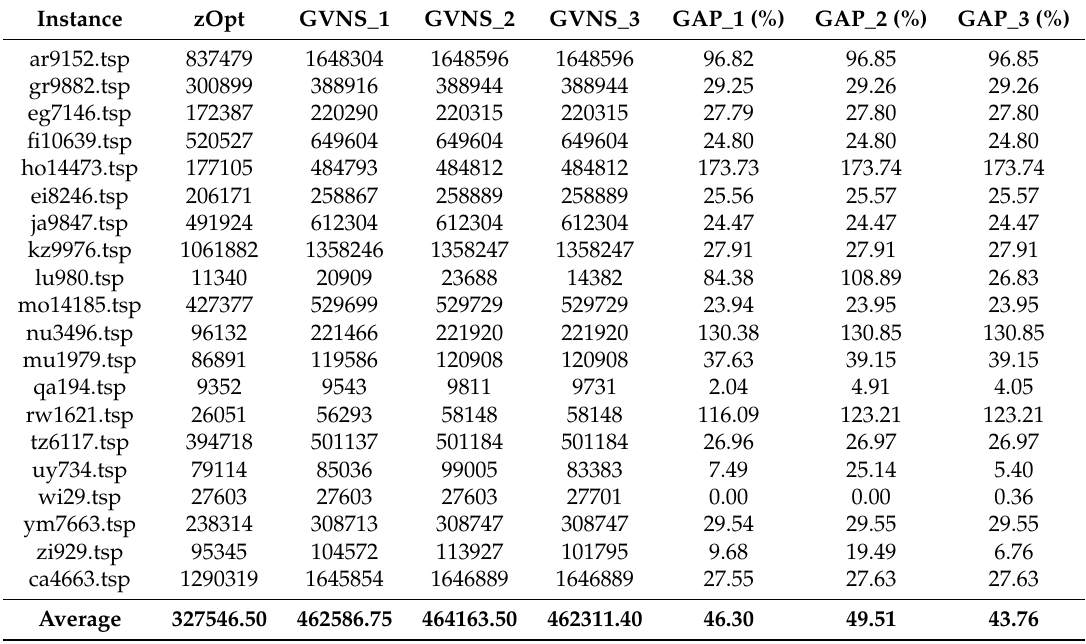
Table 11. Results using the First Improvement search strategy and an execution time limit of 2